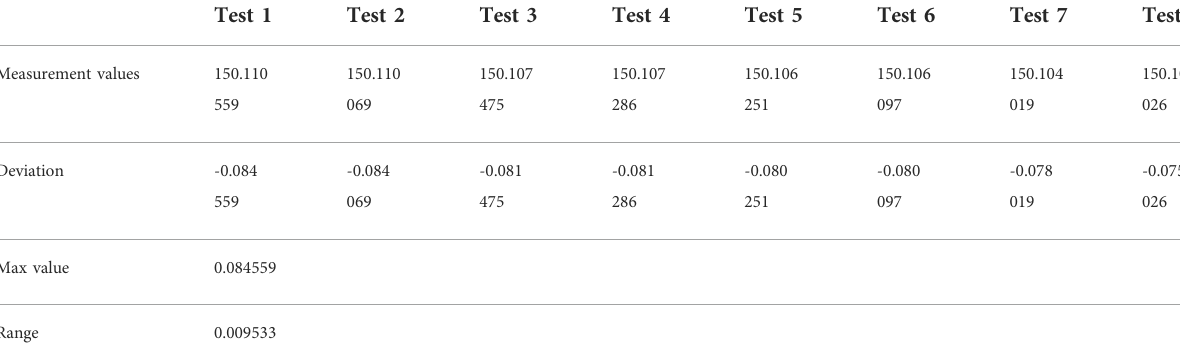
TABLE 3 Comparative results